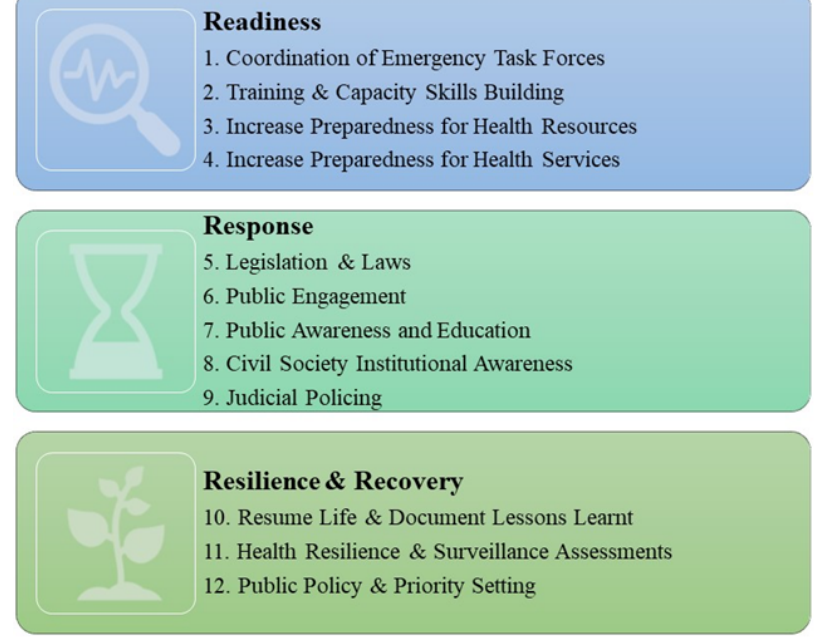
Figure 1. The 3 Rs of systematic approaches and leadership thinking required for lifting